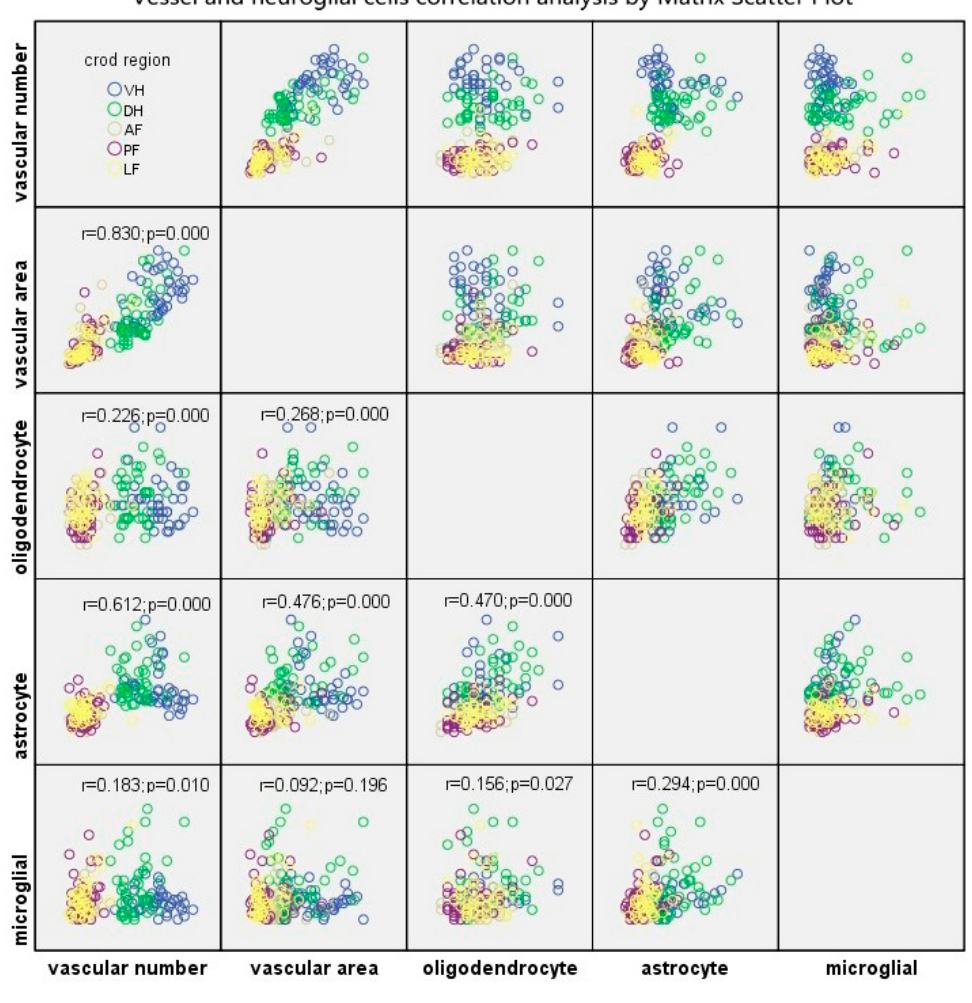
Figure 10. Interrelation among microvascular number/area and neuroglial cells including oligodendrocytes, astrocytes and microglial cells. Note: “VH”, ventral horn; “DH”, dorsal horn; “AF”, anterior funiculus; “PF”, post funiculus; “LF”, lateral funiculus.